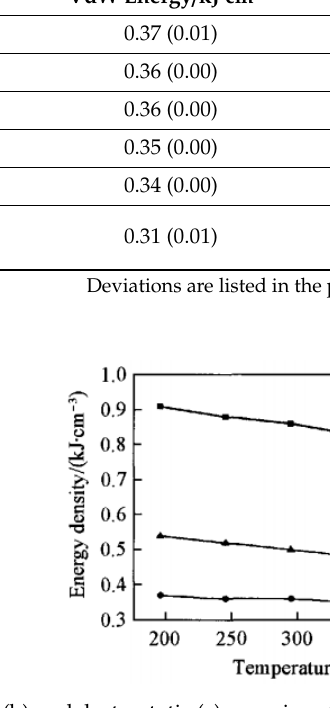
Figure 2. CED (a), vdw (b) andelectrostatic (c) energies of CL-20 / TNT cocrystal vs. temperatures [11], with permission from Chemical Journal of Chinese Universities, 2016.